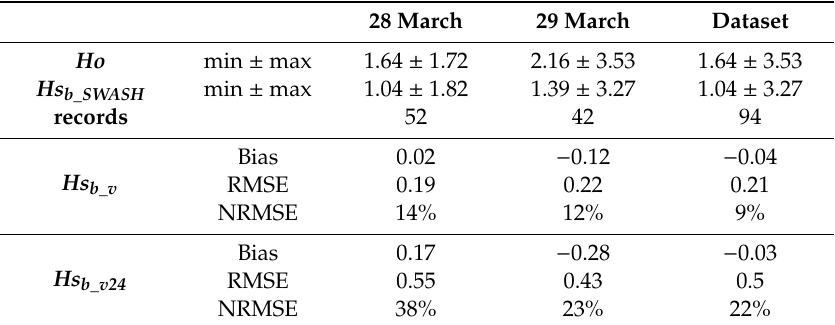
Table 2. Detailed video-derived results from Hs b , v and Hs b , v 24